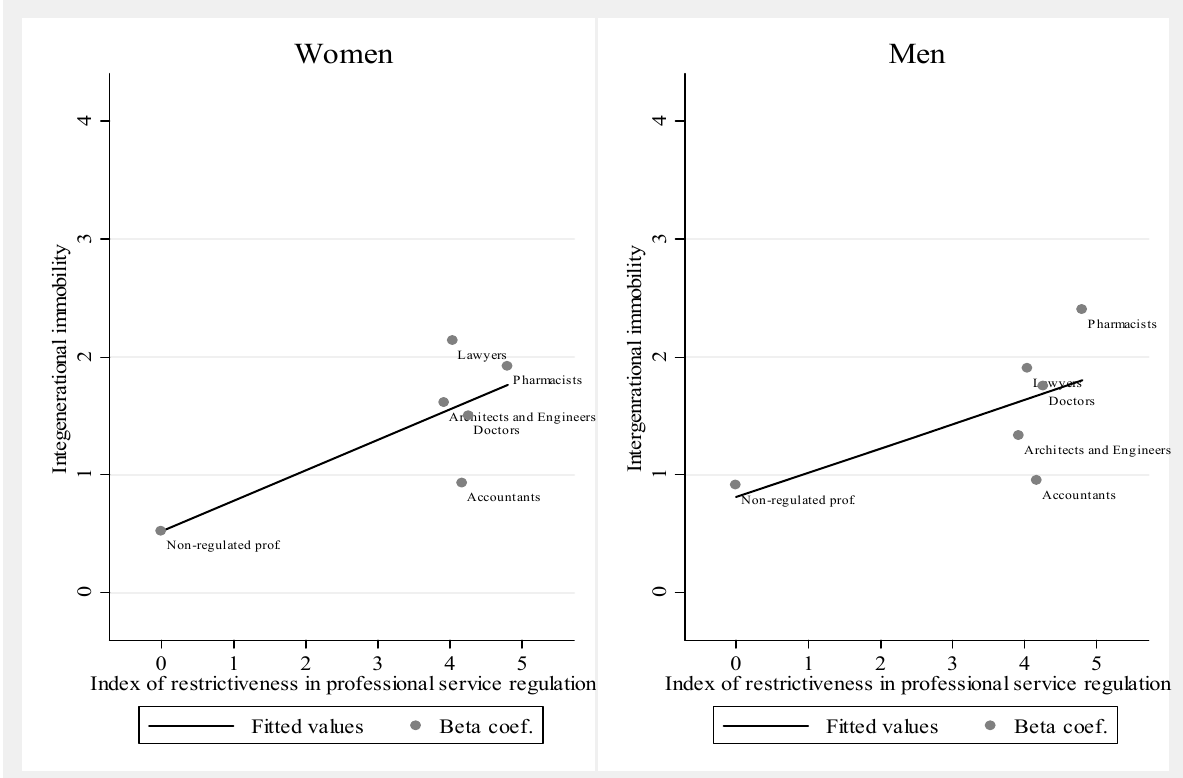
Figure 2. Correlation between entry market regulations in professional occupations (reported in Table 1) and immobility parameters for each micro-class extrapolated from model 3b.